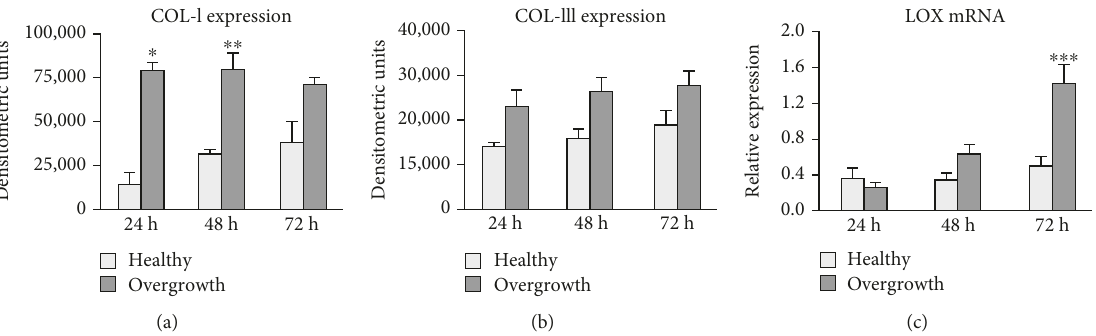
Figure 5: Collagen expression and maturation. Bar graphs showing COL-I (a) and COL-III (b) protein levels assessed by slot blot in cell culture supernatants of fi broblasts from healthy and overgrown gingivae. (c) Bar graphs showing LOX mRNA levels in fi broblasts from healthy and overgrown gingivae. GAPDH gene expression was used as internal control for normalization. Data are mean ± SD for samples run in duplicate. ∗ p < 0 01 , ∗∗ p < 0 05 , and ∗∗∗ p < 0 005 .